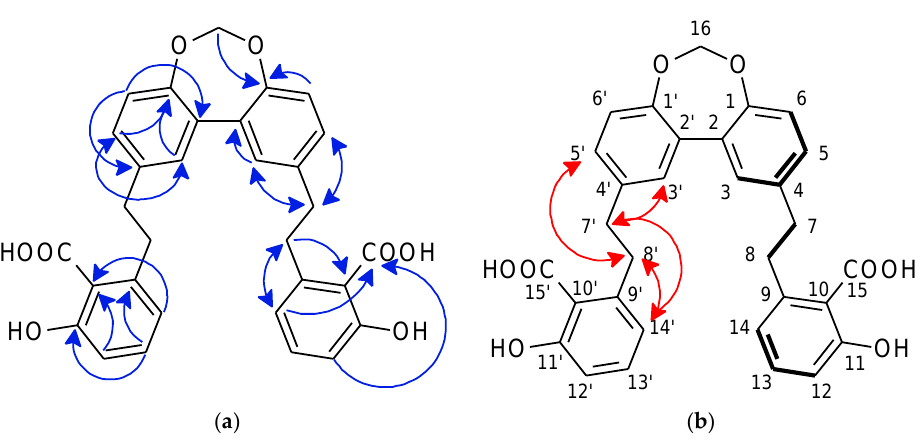
Figure 5. ( a ) HMBC (blue arrows) key correlations of compound ( 51 ); ( b ) COSY (bold) and selected NOE (red arrows) correlations of compound ( 51 ).